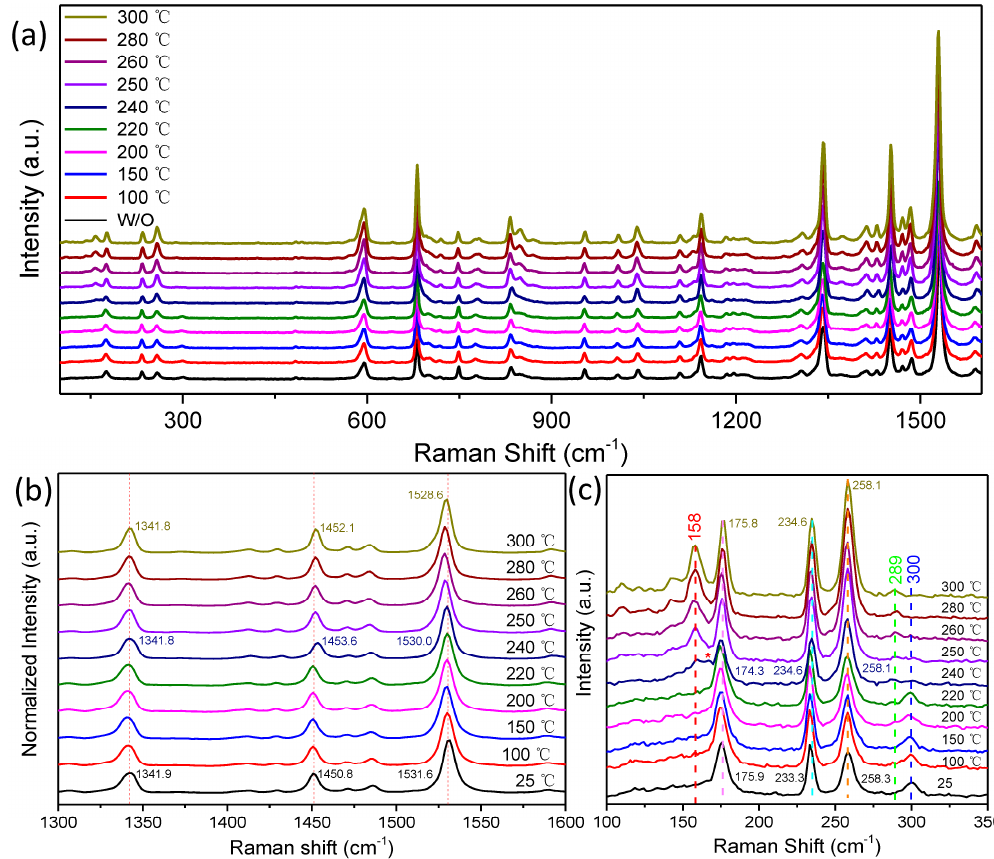
Figure 6. The Raman spectra of CuPc crystals annealed at different temperatures. The Raman spectra with the wavenumber ranging from 100 to 1600 cm − 1 are shown in ( a ), while more detailed spectra with the wavenumber at high (1300–1600 cm − 1 ) and low regions (100–350 cm − 1 ) are shown in ( b , c ), respectively.